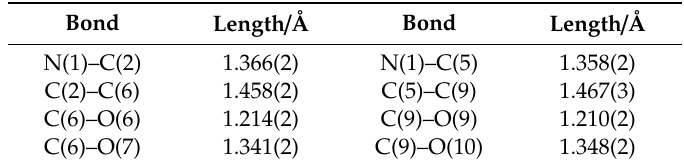
Figure 1. The molecular structure of 1 with numbering scheme. Table 1. Selected bond lengths. Table 1. Selected bond lengths.